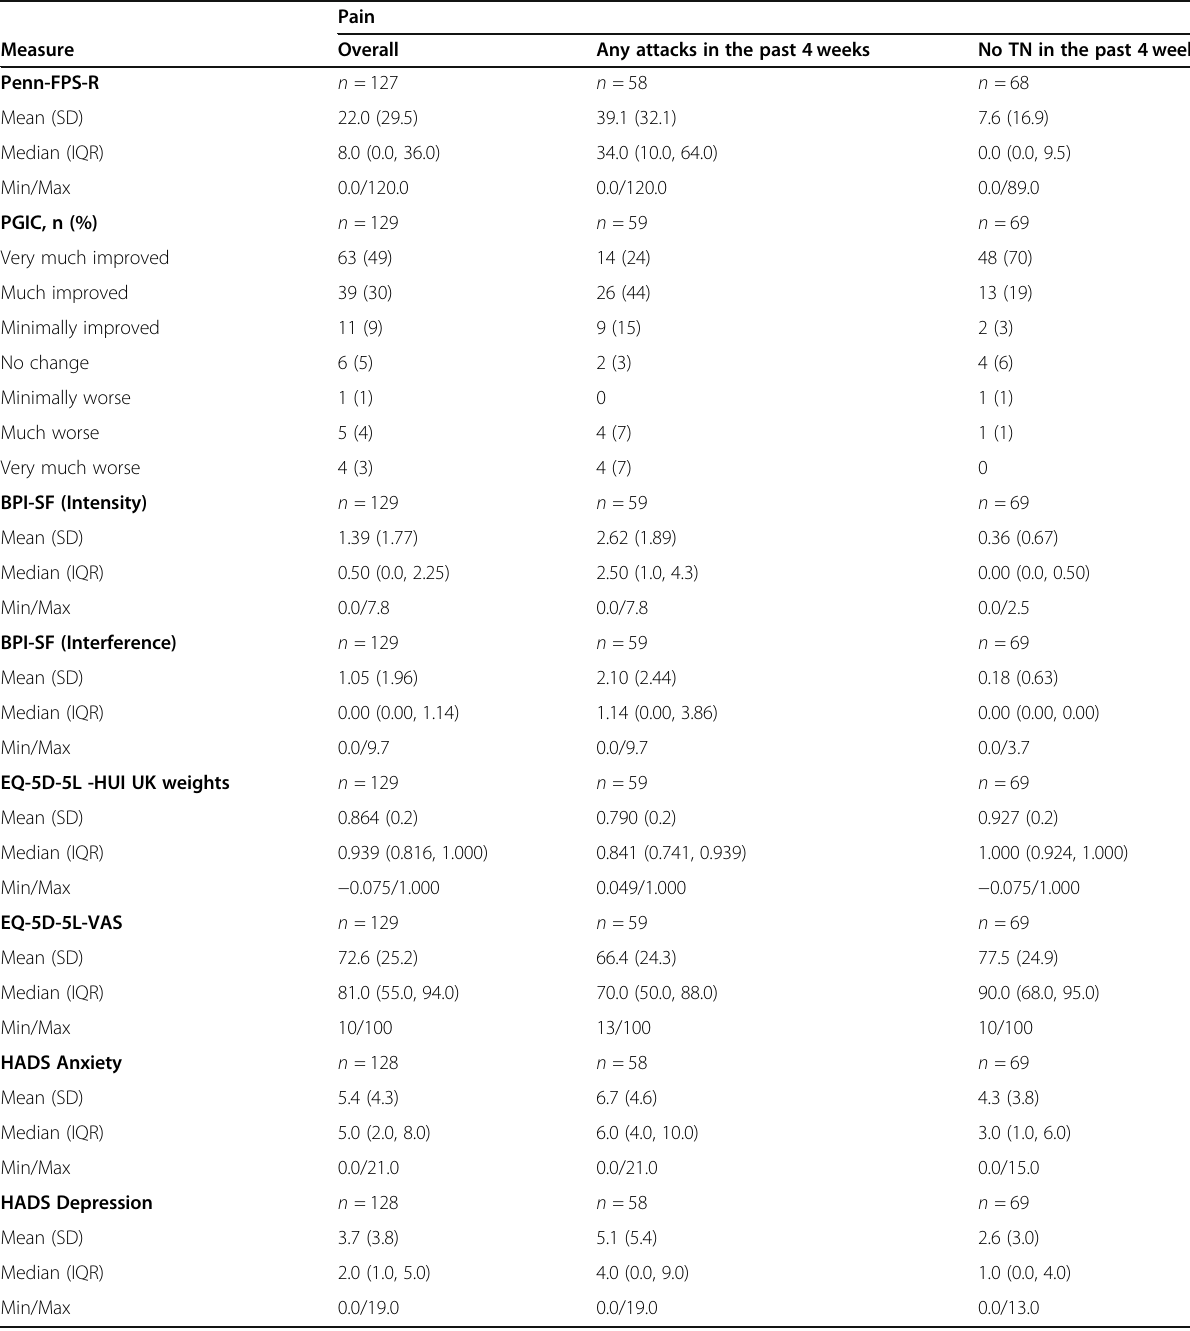
Table 8 PRO Scores by TN Attack